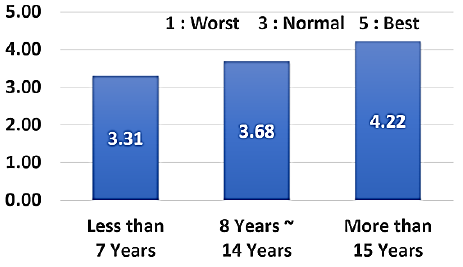
Figure A5. Users’ understanding on the term ‘WPT’ by experience of GPS plotter usage. Average (1: Worst to 5: Best). (1: Worst to 5: Best).